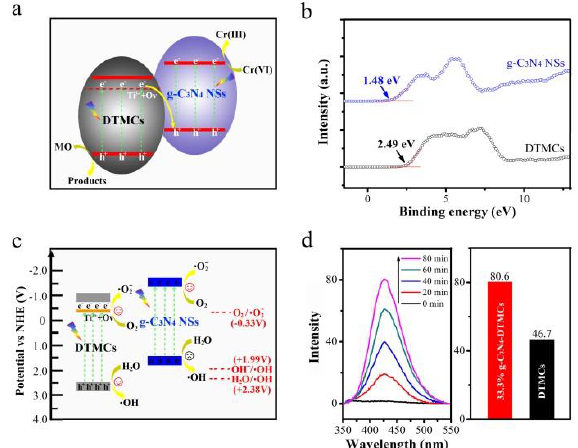
Figure 18. ( a ) Proposed Z-scheme charge-carrier transfer within DTMC / g-C 3 N 4 composite. ( b ) XPS valence band spectra and ( c ) schematic electronic band structures of DTMCs and g-C 3 N 4 NSs. ( d ) ·OH-trapping PL spectra of DTMCs / g-C 3 N 4 and the corresponding fluorescence intensity upon DTMCs / g-C 3 N 4 in comparison to DTMCs. Reprinted with permission from [183]. Copyright John Wiley & Sons Inc., 2018.